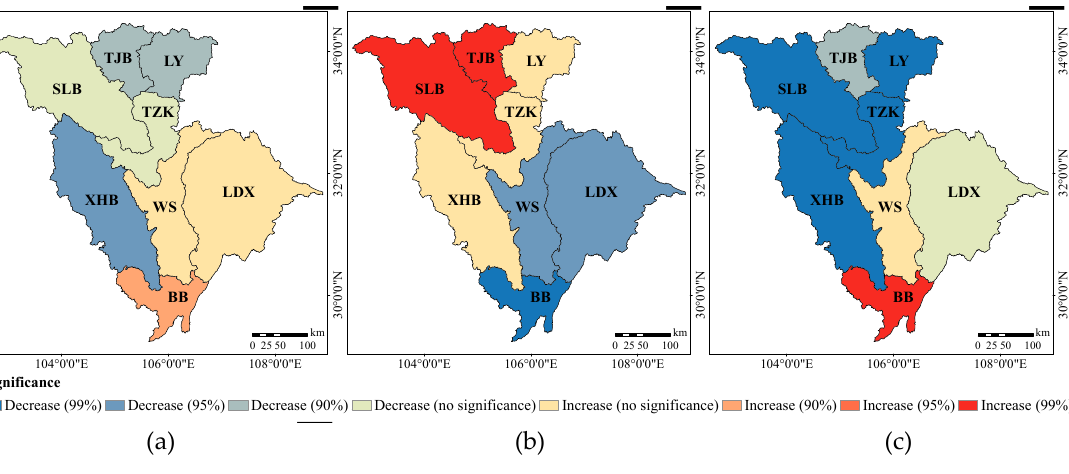
Figure 2. Changing trends and significance for ( a ) P , ( b ) E 0 , and ( c ) R by Z statistics of the Mann–Kendall test.